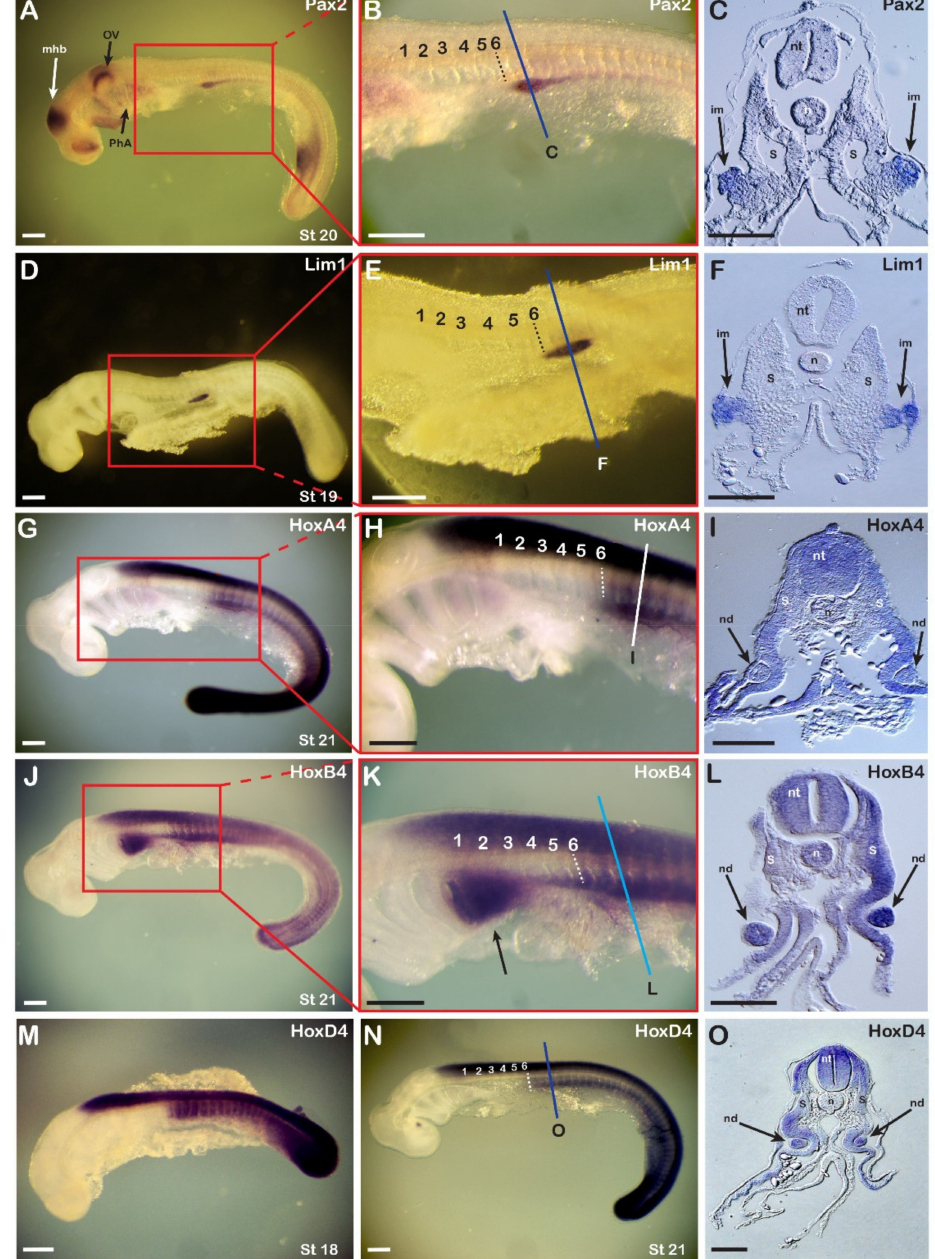
Figure 1. Expression of catshark nephric genes in relation to expression of catshark Hox4 genes. ( A – C ) The expression pattern of catshark Pax2 . n = 25. ( A ) Stage 20 embryo. ( B ) Enlargement of the boxed area shown in ( A ). ( C ) Cross section at the region marked with a line in ( B ) showing expression of the Pax2 gene in the intermediate mesoderm (arrows). ( D – F ) Expression pattern of catshark Lim1 . n = 20. ( D ) Stage 19 embryo. ( E ) Enlargement of the boxed area shown in ( D ). ( F ) Cross section at the region marked with a line in ( E ) showing expression of the Lim1 gene in the intermediate mesoderm (arrows). ( G – I ) Expression pattern of catshark HoxA4 . n = 10. ( G , H ) In a stage 21 embryo, the anterior expression boundary in the neural tube is at the level of the third branchial arch and in the mesoderm at the level of mid-somite 6 (dashed line). ( I ) Cross section at the region marked with a line in ( H ) showing expression of the HoxA4 gene in the nephric duct (arrows). ( J – L ) Expression pattern of catshark HoxB4 . n = 10. ( J ) Stage 21 embryo. ( K ) Enlargement of the boxed area shown in ( J